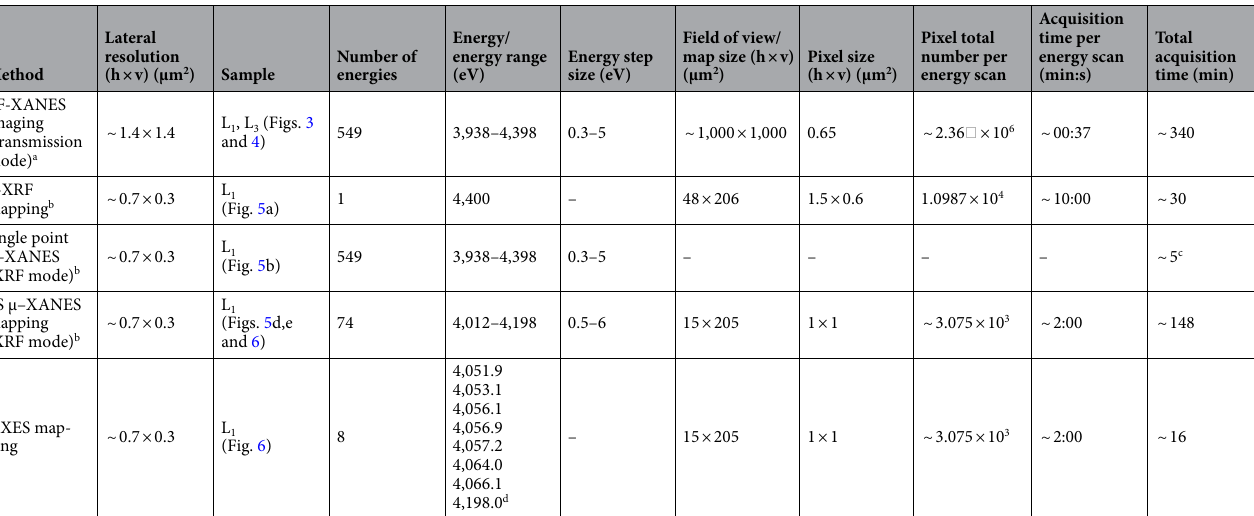
Table 1. Experimental conditions used for performing calcium speciation investigations of the consolidated Lecce stone mock-up. a Flux: ~ 10 12 ph/s [unfocused beam, diameter (h × v): ~ 1.5 × 1.5 mm 2 ]. b Flux: ≈ 2 × 10 10